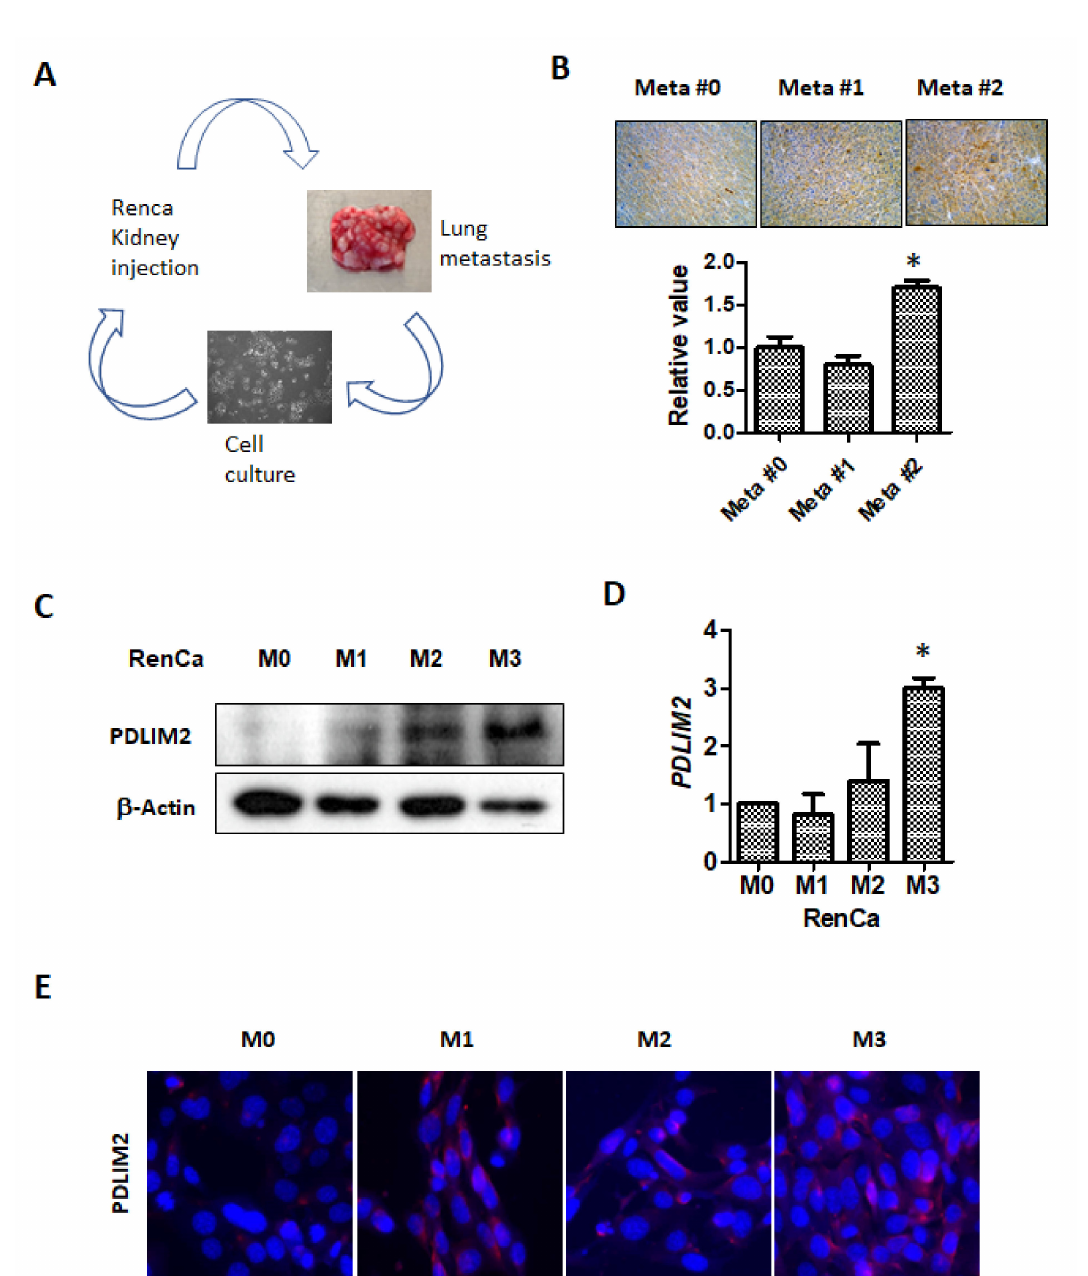
Figure 4. PDLIM2 levels were elevated in metastatic murine kidney cells. ( A ) Schematic of metastatic RenCa-M1 cells transforming into RenCa-M3 cells. ( B ) Immunohistochemistry images of PDLIM2 expression in the indicated orthotopic tumors of metastatic RenCa cells. Three different areas from each image were quantitated using the Image J program and plotted. Bars represent the mean ± standard deviation (SD) of three independent experiments, and * denotes p < 0.05 (Student’s t -test) versus the M0 group. ( C ) The protein levels of PDLIM2 in control and metastatic RenCa cells were measured using whole cell extracts. ( D ) The mRNA levels of PDLIM2 in the indicated cells were measured using RT-qPCR. Bars represent the mean ± SD of three independent experiments, and * denotes p < 0.05 (Student’s t -test) versus the sh-con group. ( E ) Immunofluorescence staining of PDLIM2 in original (M0) and metastatic RenCa (M1–M3)